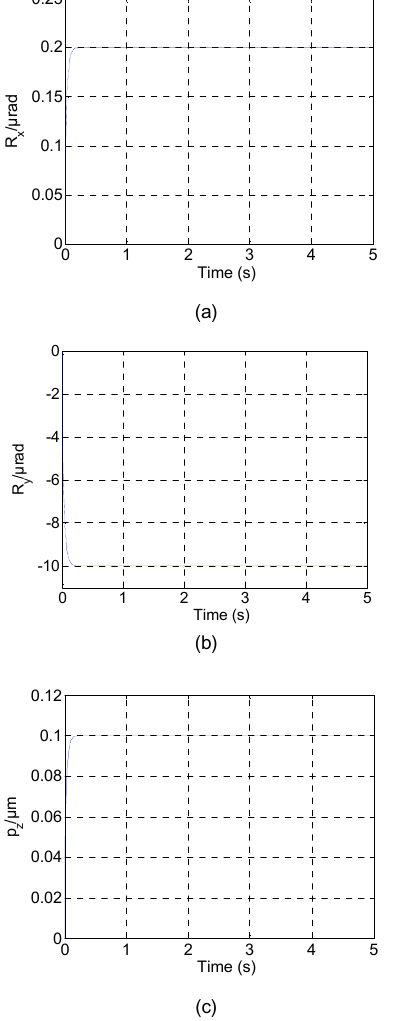
Figure 9. Out pose simulation results: (a) R x , (b) R y , (c) P z .